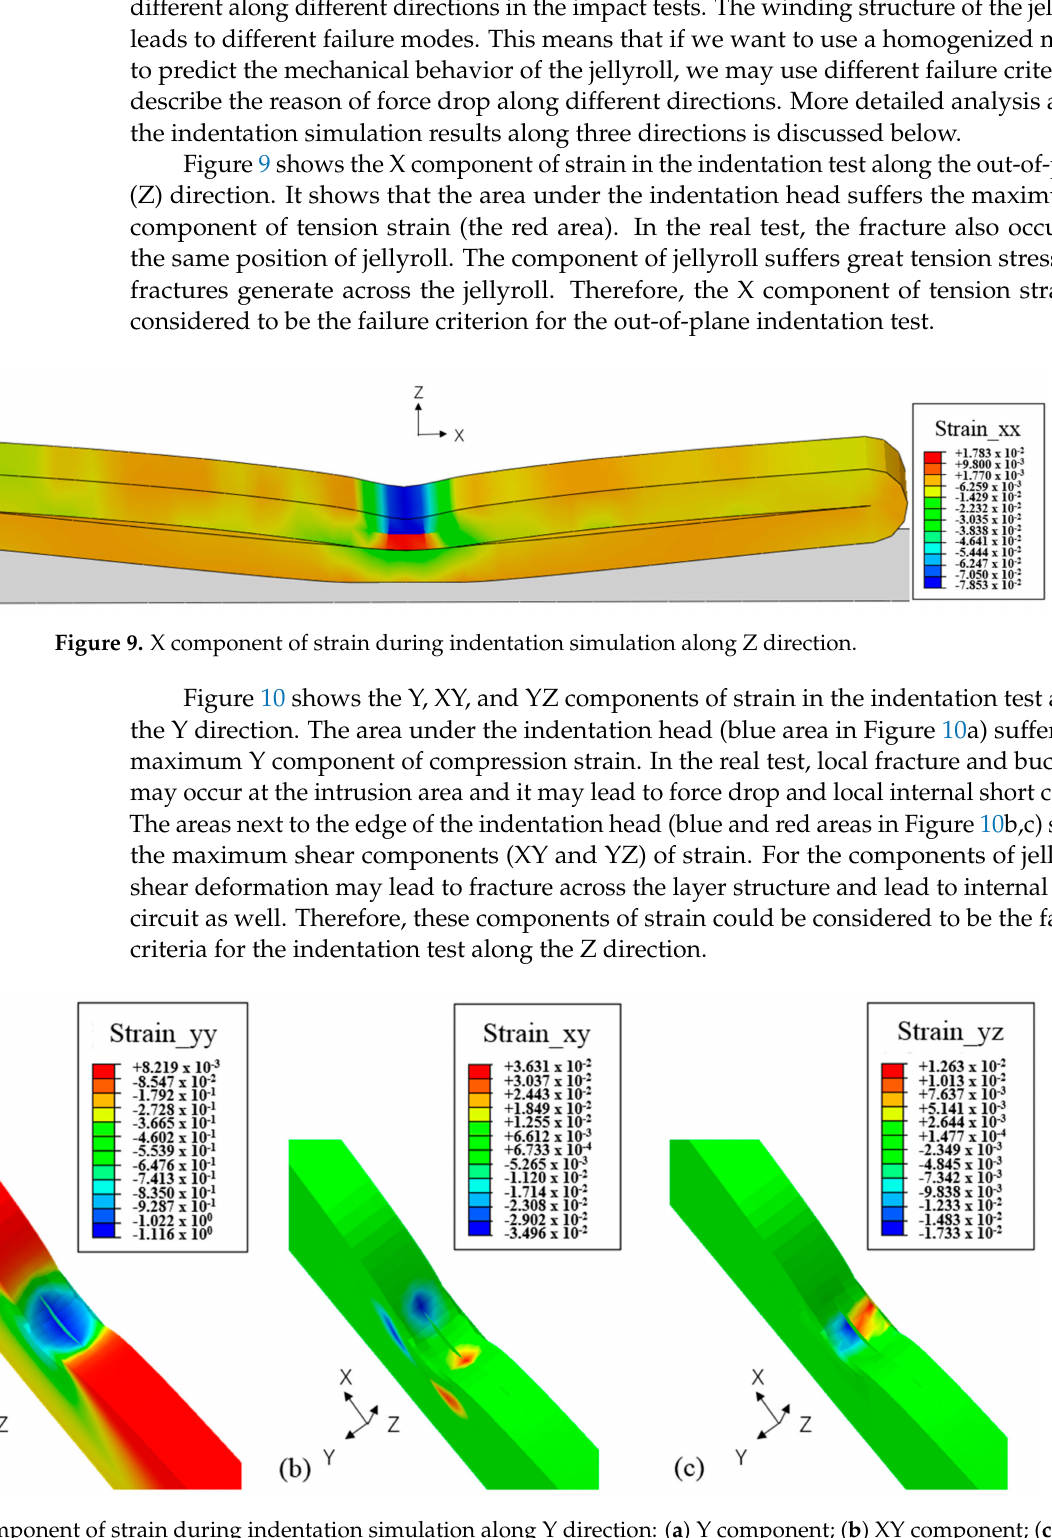
Figure 10. Component of strain during indentation simulation along Y direction: ( a ) Y component; ( b ) XY component; ( c ) YZ